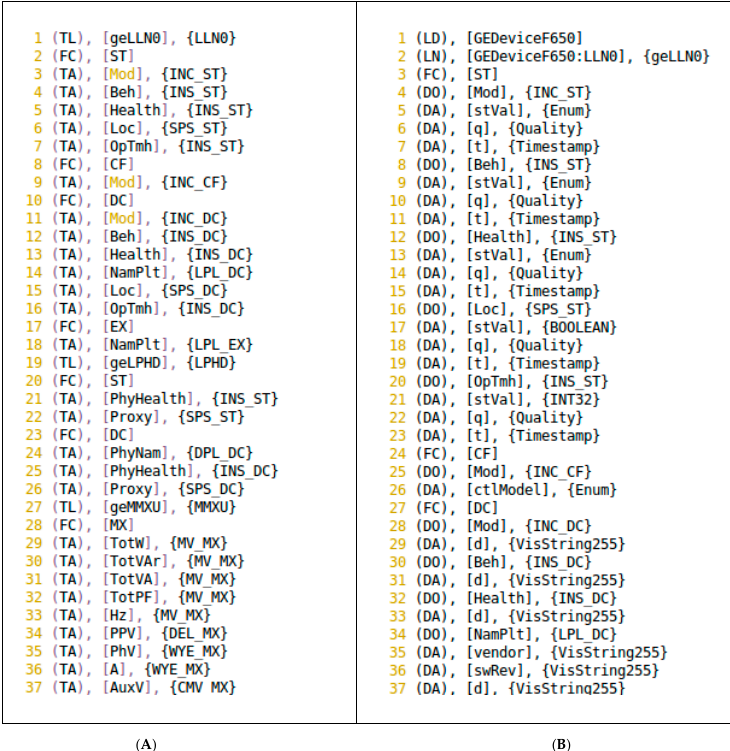
Figure 10. Examples of TDF and NDF. ( A ) Example of a created TDF file. Parentheses indicate the data type—(TL) is the type of logical node, (FC) is the functional constraint, and (TA) is a type of data attribute. Brackets indicate the name of the data and the data for each data type and braces indicate the name of the type. ( B ) Example of a created NDF file. Parentheses indicate the data type—(LD) is an